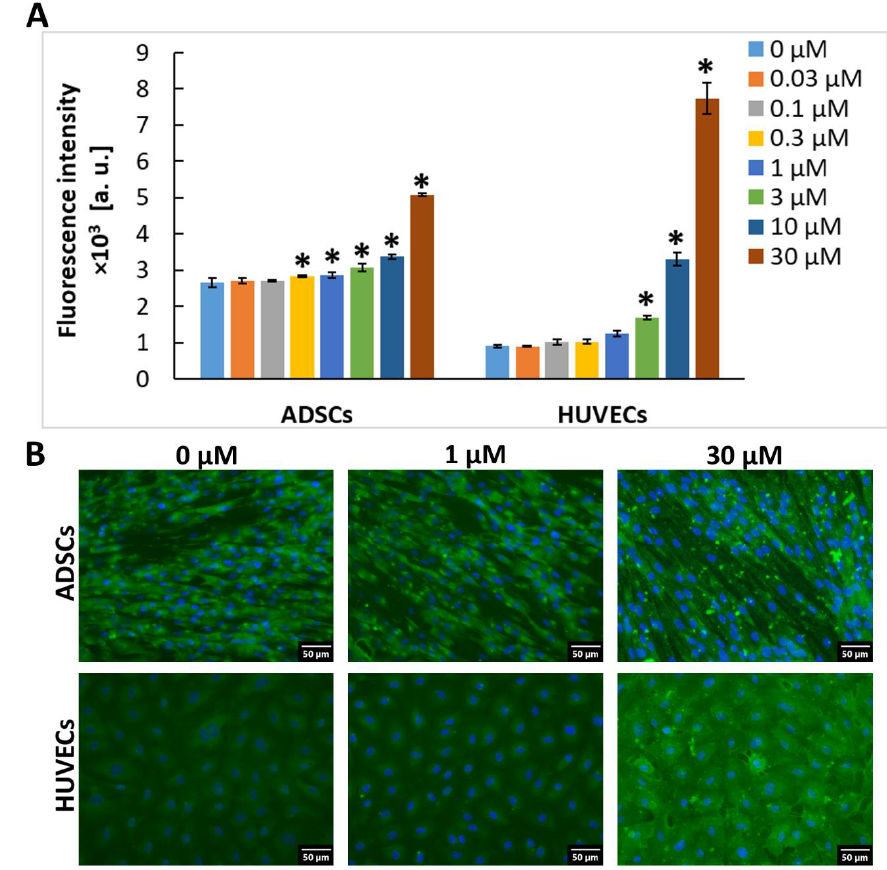
Figure 2. Association of exogenous Gal-3 with cells. For Gal-3 staining, the anti-Gal-3 antibody [EP2775Y] produced in rabbits (Abcam, Cambridge, UK; Cat. No. ab76245) was used. ( A ) The intensity of the fluorescence signal in wells with ADSCs and HUVECs after 1 h of incubation in a cultivation medium containing Gal-3 in a concentration range from 0 to 30 μM. The data are presented as the mean ± SD from 3 wells. Holm-Sidak test, p ≤ 0.05. The samples were statistically compared within the group of the indicated cell type. * Statistically significant difference in comparison with the control sample without the added Gal-3 (0 µM). ( B ) Representative images of immunofluorescence of Gal-3 in ADSCs and HUVECs after 1 h of incubation in a pure cultivation medium without Gal-3 (0 μM) and in the medium with 1 μM or 30 μM Gal-3. The cell nuclei were counterstained with Hoechst 33258. Olympus IX 71 microscope, DP 70 digital camera, obj. 20×, scale bar 50 μm.